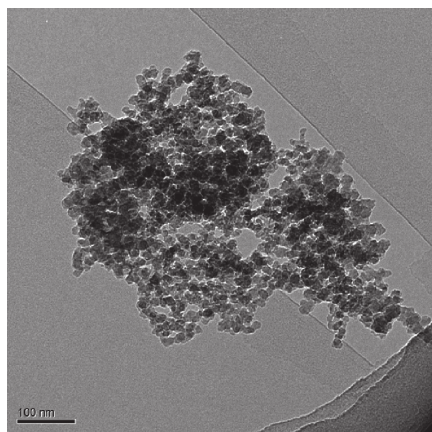
Figure 2: TEM image of